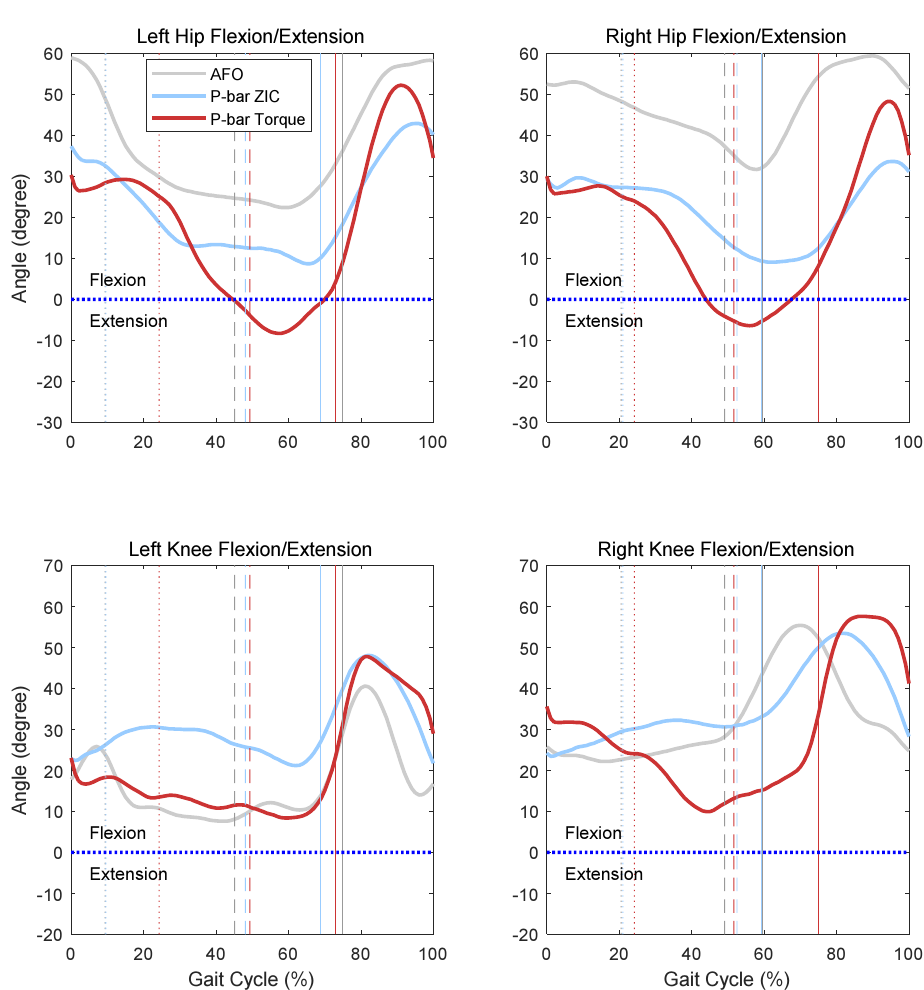
Figure 11. Kinematic result of a patient with spina bifida with Angel Legs and using parallel bars. The solid gray line represents data without Angel Legs, the light blue line represents data with Angel Legs without assistive control, and the red line represents data with assistive control. Vertical lines represents the gait phases. Dotted vertical lines represent the single limb support phase (opposite foot off), dashed vertical lines represent the second double limb support phase (opposite foot contact), and solid vertical lines represent initial